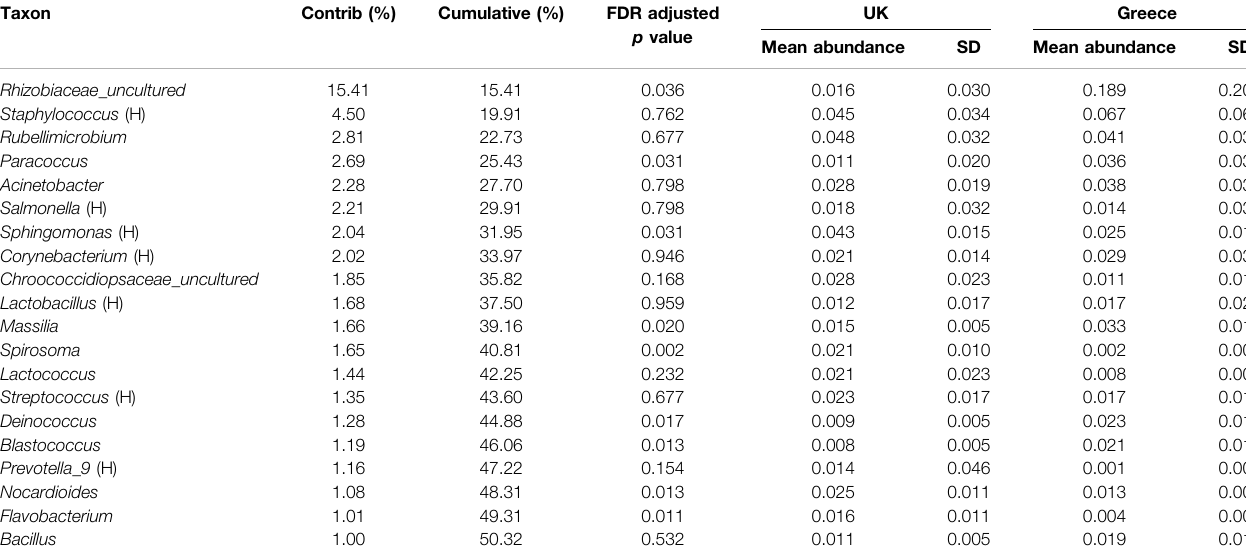
TABLE1| SIMPERanalysisofsigni fi canttaxadrivingdiversityatgenuslevel.Signi fi cancetestingperformedusingKruskal-Wallisone-wayanalysisofvarianceaccountingfor false discovery rates. Greyed out rows fail to meet the statistical signi fi cance cut off value of p < 0.05. H in parentheses denotes a commonly human associated Genus.